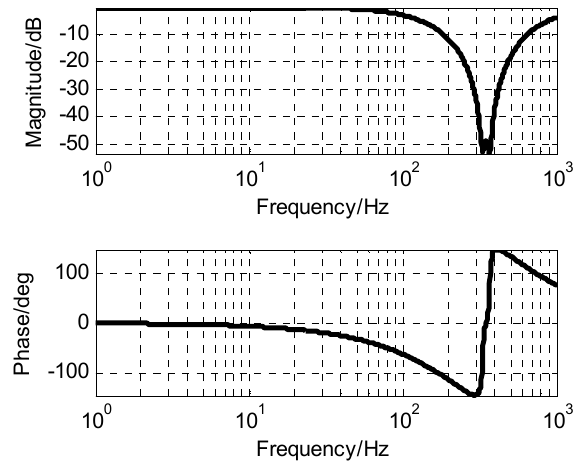
Figure 8. The frequency characteristic of notch